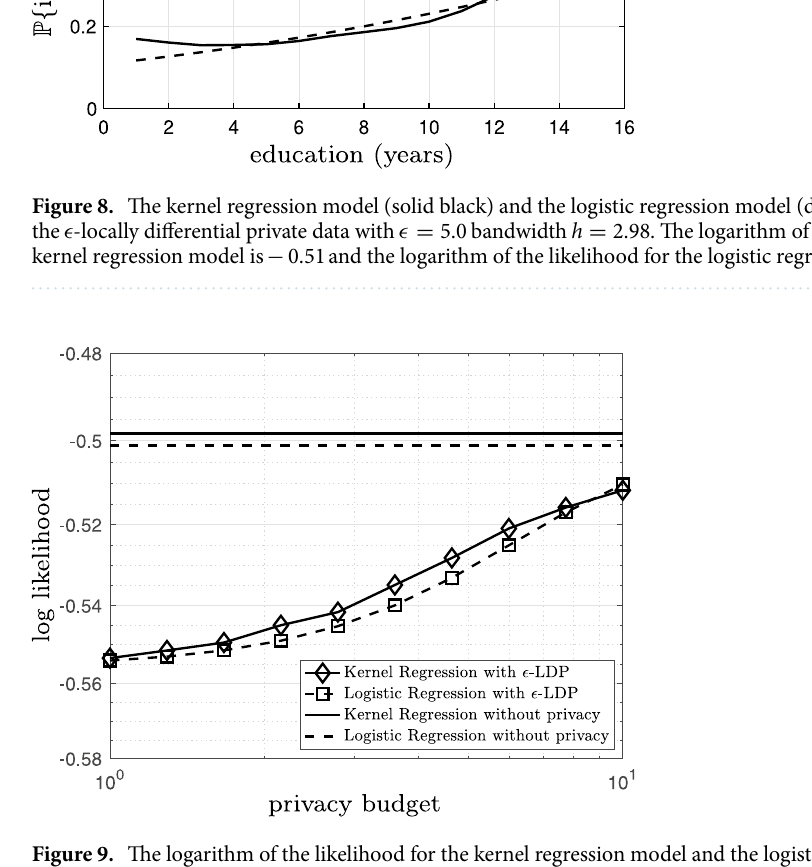
Figure 9. The logarithm of the likelihood for the kernel regression model and the logistic regression model based on the ǫ -locally differential private data versus privacy budget ǫ . The horizontal lines show the logarithm of the likelihood for the kernel regression model and the logistic regression model based on original noiseless